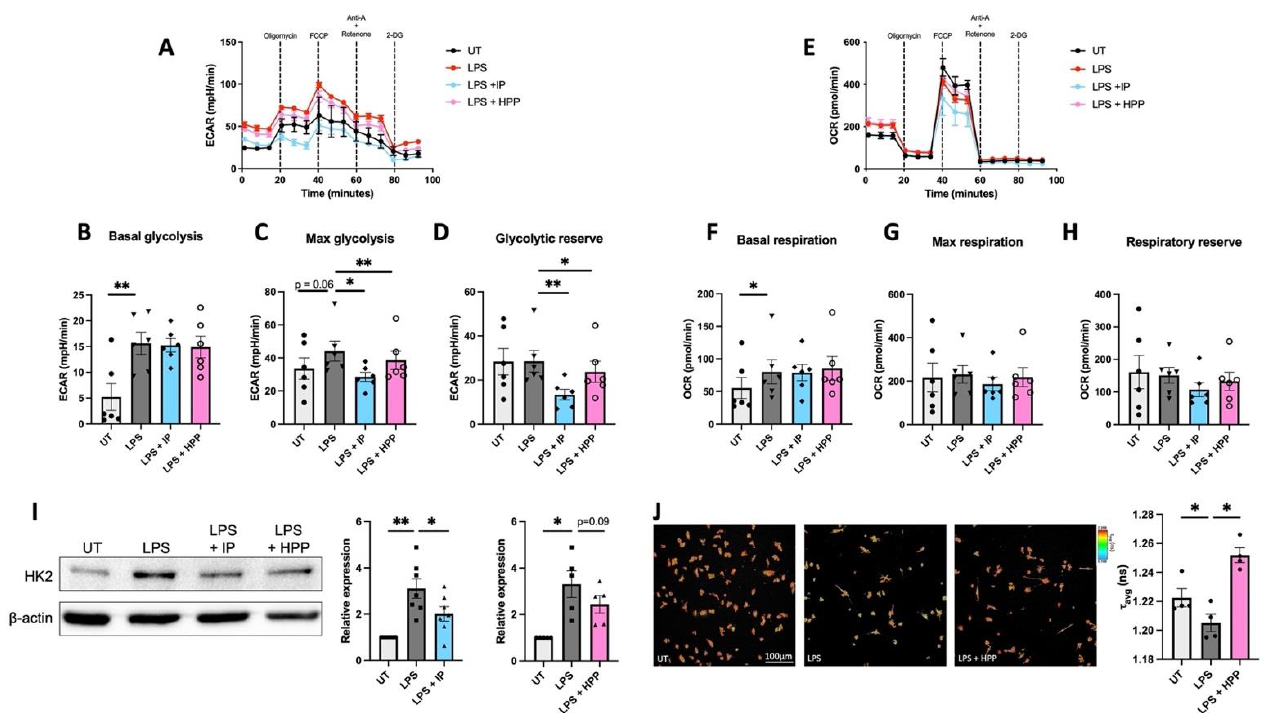
Figure 5. HPP and IP modulate metabolic reprogramming in LPS-stimulated DC. Primary human DC were pre-treated with either HPP or IP at 1000 µ M for 6 h before stimulation with LPS (100 ng/mL) for 12 h. The extracellular acidification rate (ECAR) and the oxygen consumption rate (OCR) were measured using a Seahorse XFe96 analyser before and after the injections of oligomycin (1 mM), FCCP (1 mM), antimycin A (500 nM) and rotenone (500 nM), and 2-DG (25 mM). Bioenergetic profiles from one representative experiment depicting ( A ) ECAR and ( E ) OCR measurements over time. Pooled data ( N = 6) depicts the calculated mean ( ± SEM) of ( B ) basal glycolytic rate, ( C ) max glycolytic rate, ( D ) glycolytic reserve, ( F ) basal respiratory rate, ( G ) max respiratory rate, and ( H ) respiratory reserve for each treatment group. ( I ) HK2 expression was measured by western blot. Densitometry results shown are mean ± SEM of the relative expression of HK2: β -actin from five to seven healthy donors. ( J ) FLIM images of DC measuring intracellular NADH. Pooled data ( N = 4) depicts the mean ( ± SEM) of the ratio of bound:free NADH, represented by the τ average. Repeated measures one-way ANOVA, with Dunnett’s multiple comparisons post hoc test, was used to determine statistical significance by comparing means of treatment groups against the mean of the control group (** p < 0.01, * p < 0.05). ImageLab (Bio-Rad) software was used to perform densitometric